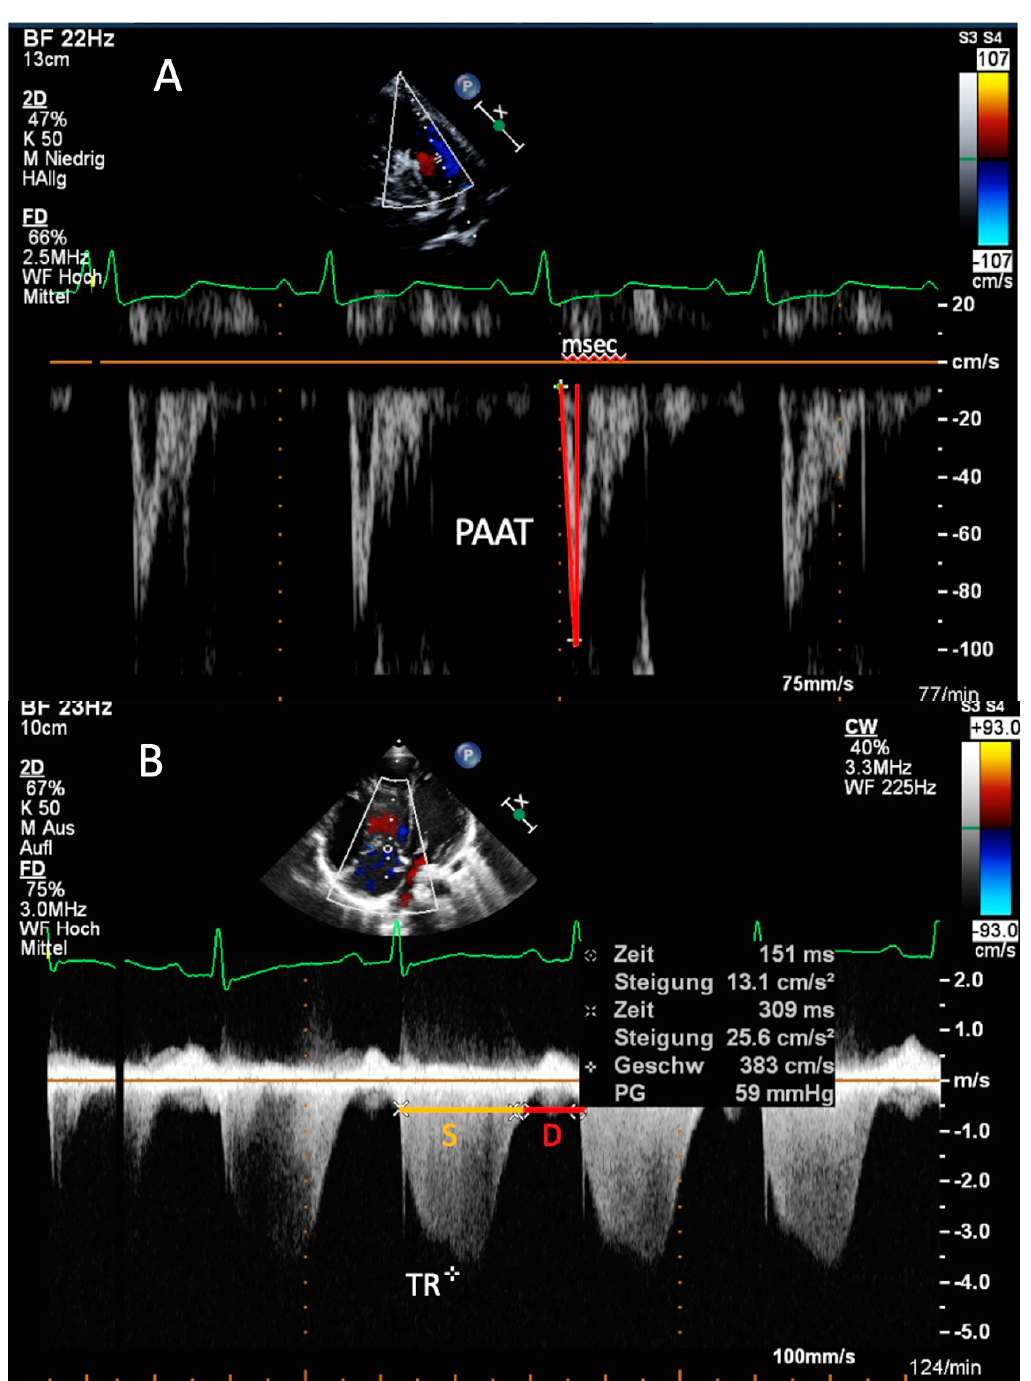
Figure 1. Transthoracic imaging. ( A ) Parasternal short-axis view. Measurement of the pulmonary artery acceleration time (PAAT) in an 8-year-old male patient with pulmonary arterial hypertension associated with congenital heart disease (PAH-CHD). The red lines mark the rapid acceleration to peak flow velocity in early systole, followed by a fast deceleration in mid-systole. Compared to healthy subjects, the PAAT of 55 ms measured over 4 circles is reduced in this patient. ( B ) Apical four-chamber view. Determination of Doppler-derived systolic (S) to diastolic (D) duration ratio in a 12-year-old patient with idiopathic pulmonary arterial hypertension by using tricuspid regurgitation (TR). The yellow line marks the S duration, and the red line the D duration of the cardiac circle. In this patient, the S/D ratio is increased (S/D ratio = 1.9).